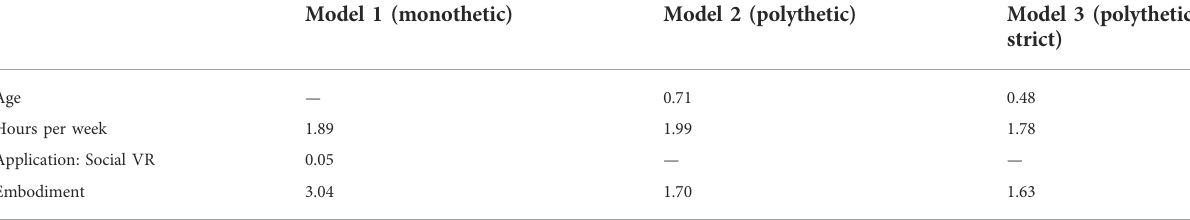
TABLE 3 Odd rations (effect sizes) for the signi fi cant predictors in the three binomial logistic regression models. Model 1